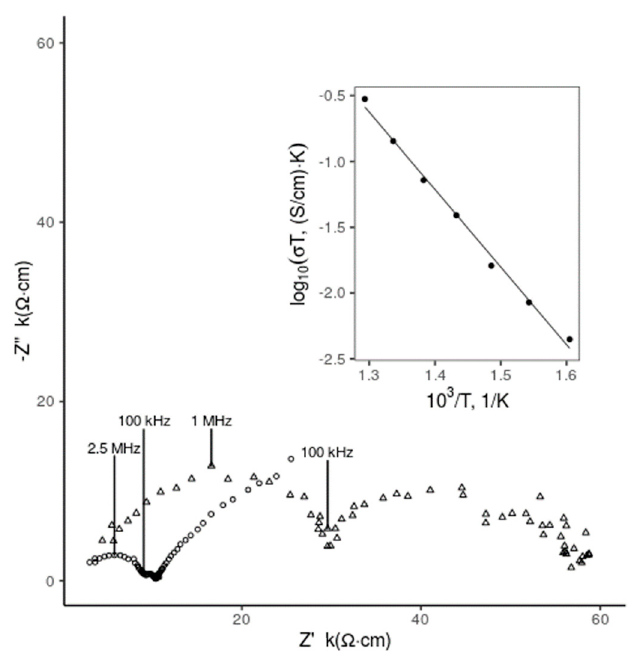
Figure 2. EIS spectrum of 8YSZ ( ○ ) and 8YSZ with the addition of 5 mol.% MoO 2 and NiO as sintering aids ( Δ ) at 400 °C with Arrhenius conductivity plot as inset.